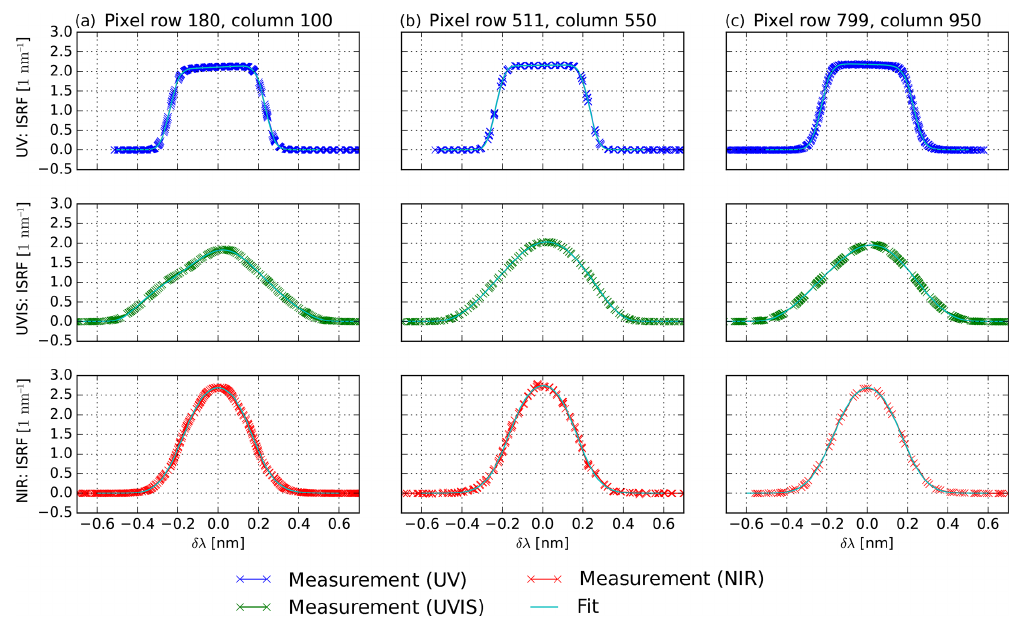
Figure 34. Extracted data and parametrized instrument spectral response functions (ISRFs) for several pixels on the UVN detectors. For each detector two pixels at diagonal opposite corners (left and right columns) and a pixel in the middle of the detector (middle column) are shown. The data for the UV and UVIS ranges are derived from laser measurements, and the data for NIR are from SFS measurements.